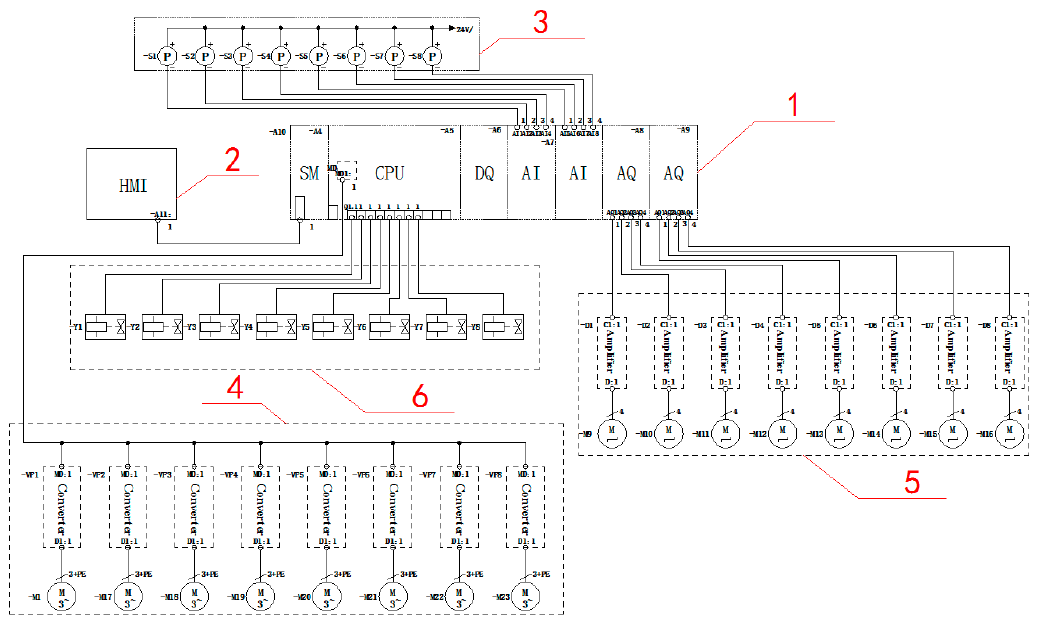
Figure 5. Design diagram of circuits of the system. 1: Programmable controller; 2: human–machine